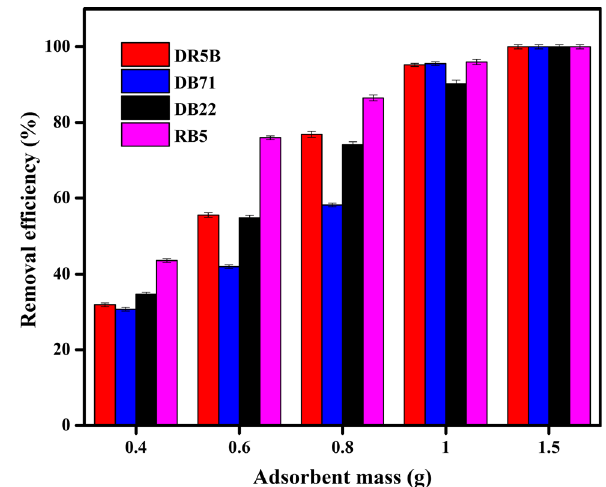
Fig. 1 Effect of pH on adsorption of DR5B, DB22, DB71, and RB5 onto spent mushroom waste Fig. 2 Effect of adsorbent dosage on the dye removal